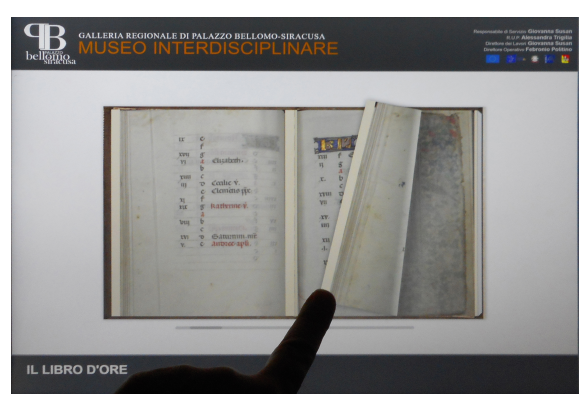
Figure 3. Touch screen presentation of a Libro d’ore , parchment book, illustrated with miniatures, by unknown Flemish artist from the beginning of the Sixteen Century; Galleria Regionale di Palazzo Bellomo, Siracuse, Italy. – Compare also with Figures 4 and 6. (Photo: